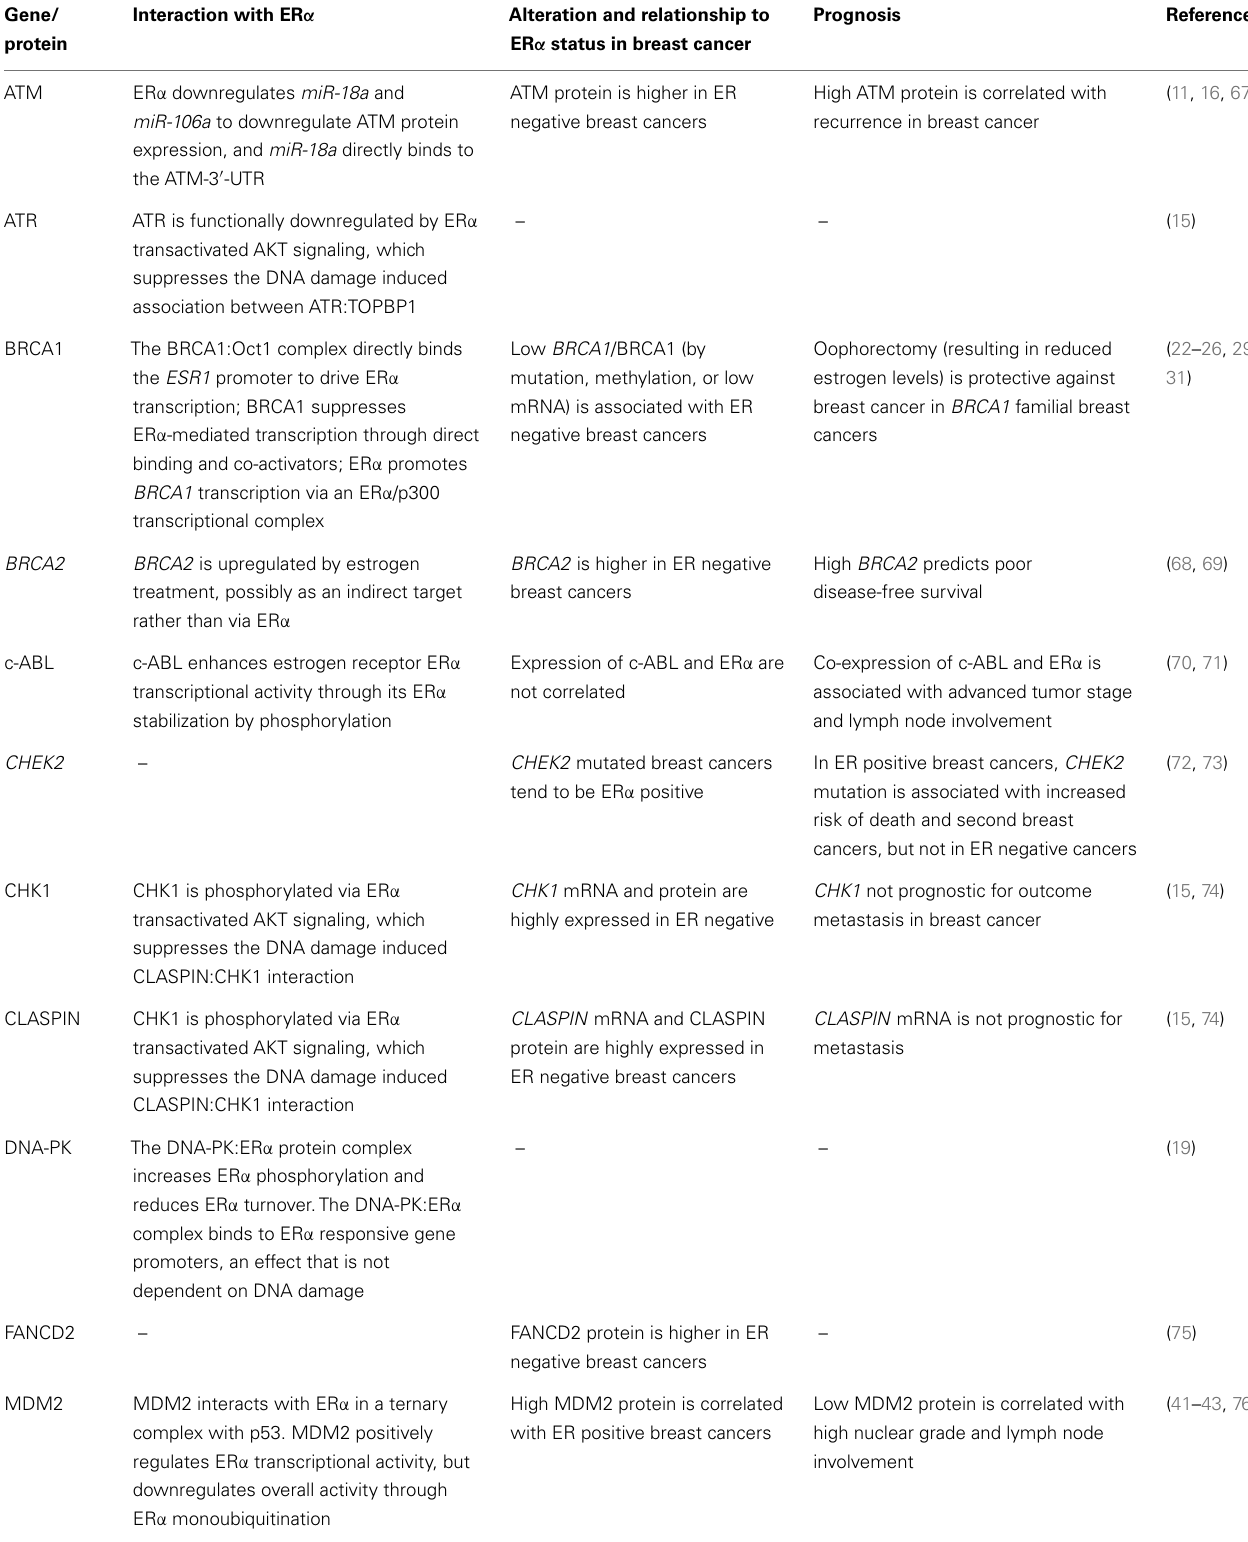
Table 1 | DNA damage response and DNA repair genes altered in breast cancer and relationship to ER α status